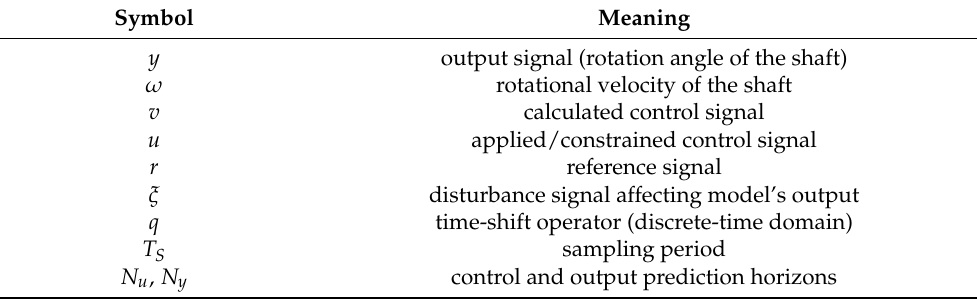
Table 2. Notation used throughout the